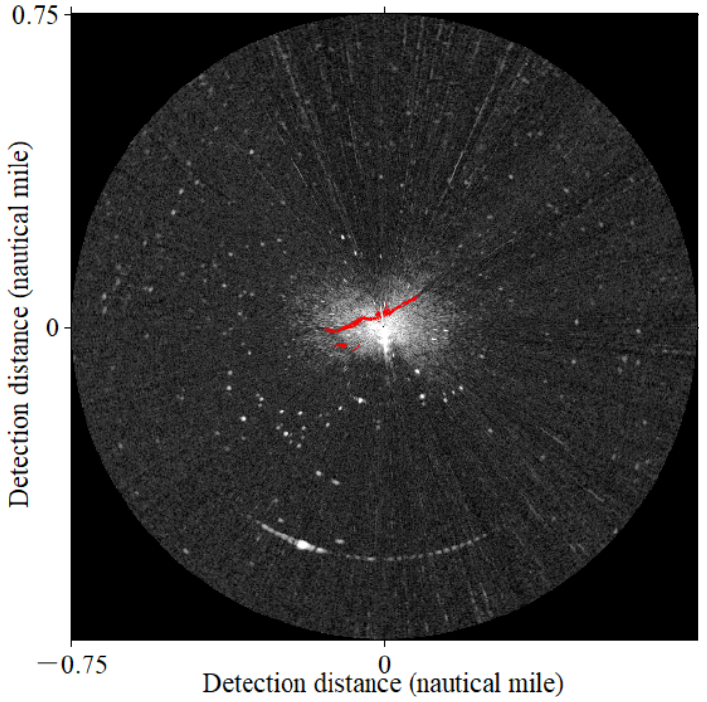
Figure 11. Oil films segmentation results in the polar coordinate system. The oil films were marked in red.